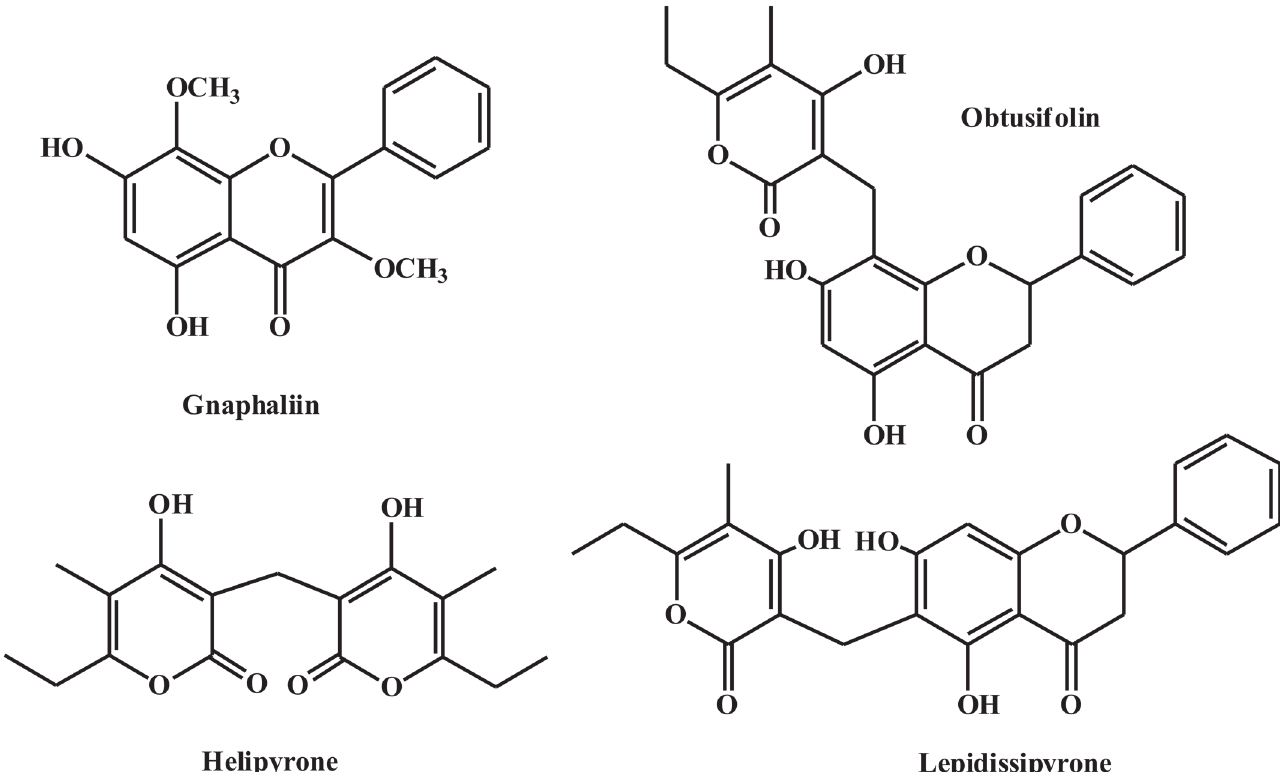
Fig 1. Chemical structures of the main identified